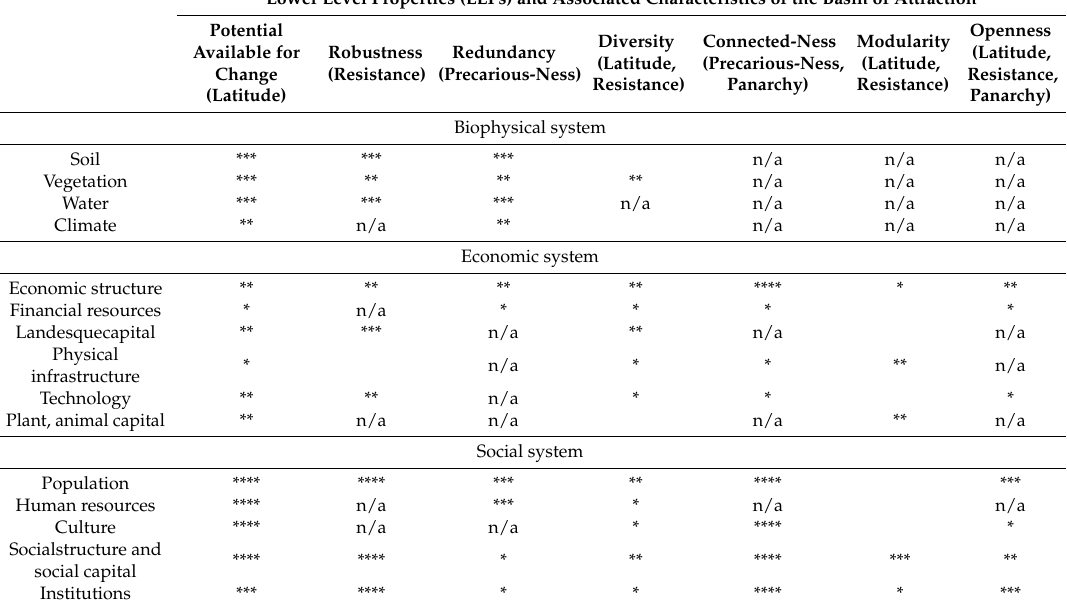
Table 8. Socioecological Resilience Assessment Matrix (SERAM) of the “Cereal modernization phase, 1950–1970”. Lower Level Properties (LLPs) and Associated Characteristics of the Basin of Attraction Potential Robustness Available for Change (Latitude)